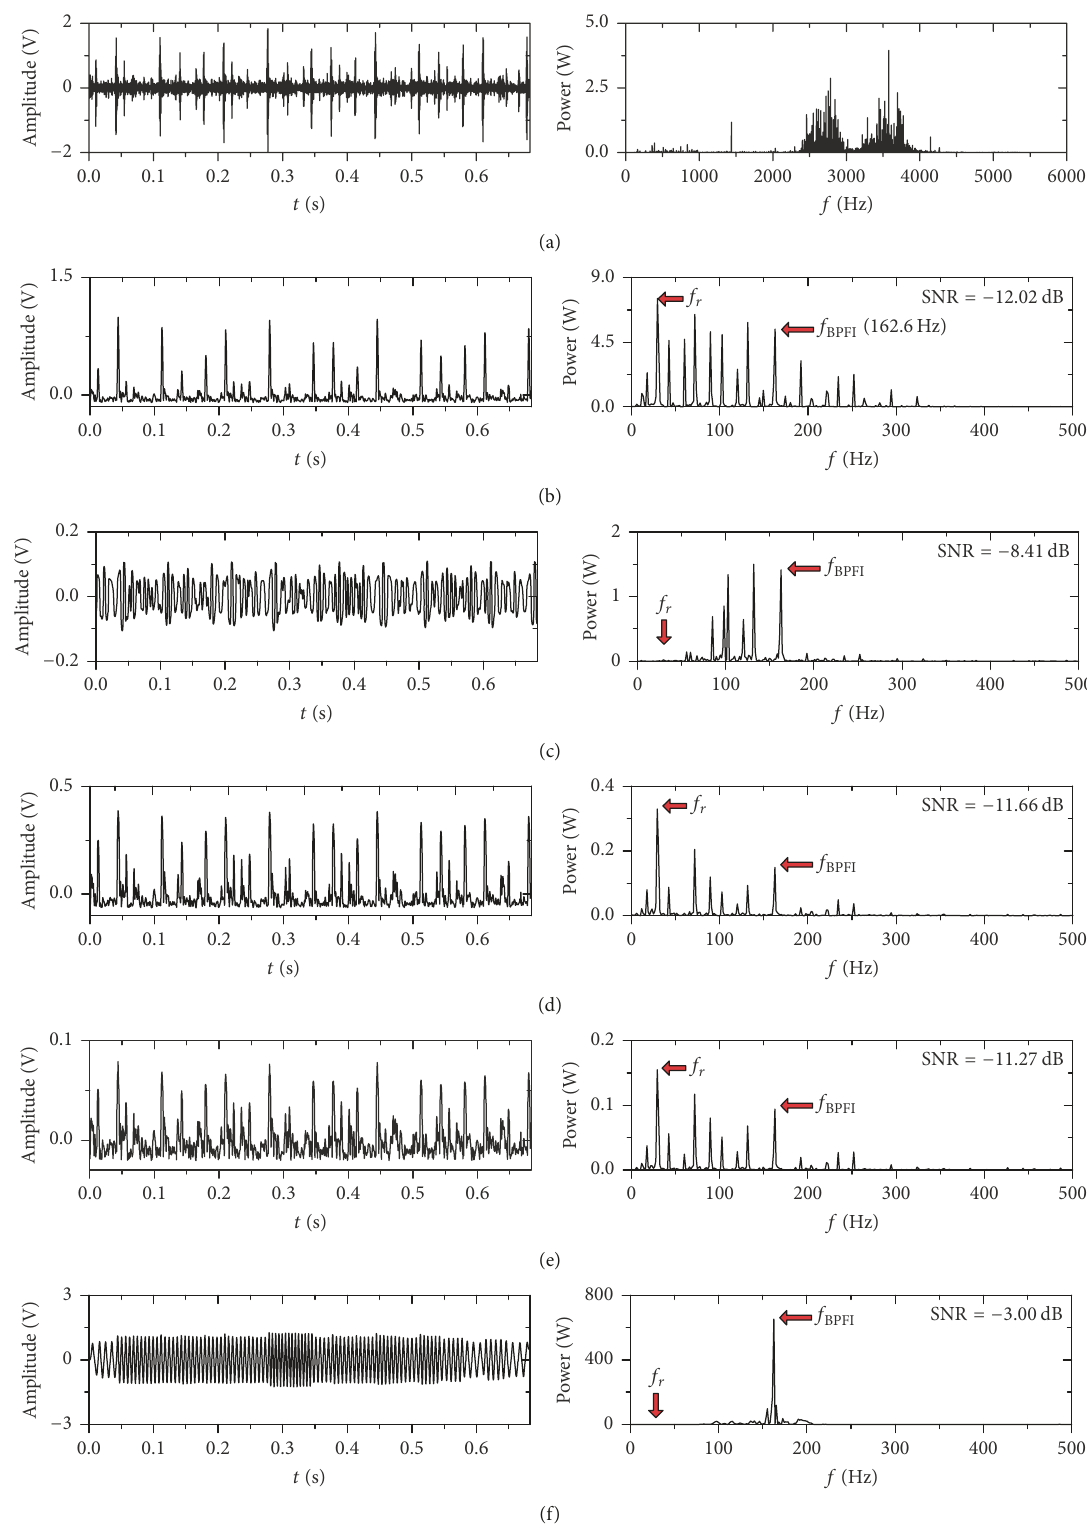
Figure 9: Analysis results for the bearing signal with a defective inner race: (a) original signal; (b) envelope signal with a filtering band at 2500–3000 Hz; (c) optimal MSTSR output signal (optimal parameters: 𝑎 = 1𝑒−6 , 𝑏 = 8827 , ℎ = 0.008 , and 𝐾 = 6 ); (d) optimal WSSR output signal (optimal parameters: 𝑅 1 = 0.3 , 𝑉 0 = 16 , 𝑐 = 0.03 , and ℎ = 0.09 ); (e) optimal WSGSR output signal (optimal parameters: 𝑅 1 = 1 , 𝑅 2 = 1 , 𝑉 = 18 , V 𝑐 = 0.4 , and ℎ = 0.2 ); and (f) optimal SVVR output signal (optimal parameters: 𝑎 = 1.2 , 𝑏 = 5 , 𝛾 = 0.008 , ℎ = 0.05 , 0 1 = 0.8, 𝐵 = 0.06 , and Ω = 36505